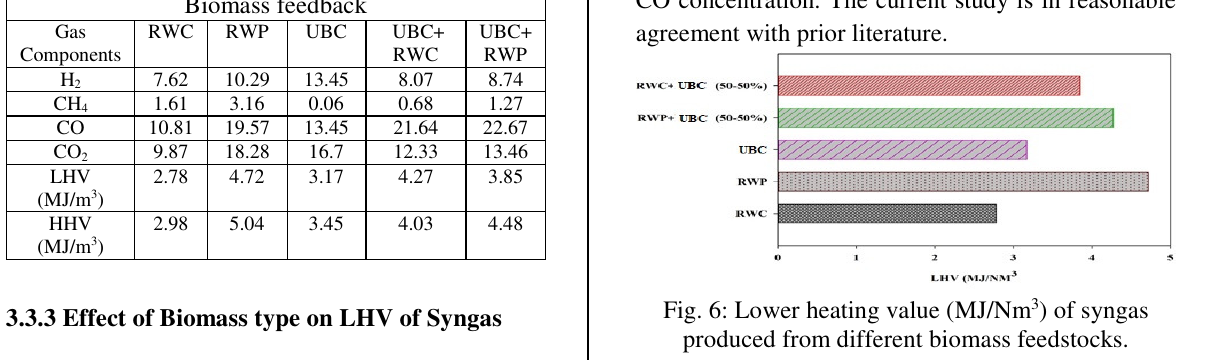
Table 4: Lower and Higher Heating Values of Syngas from Different Biomass Feedstocks